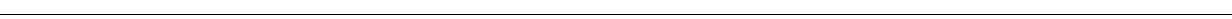
Figure 6 | Motor neuron-selective deletion of FUS does not cause MN degeneration. ( a ) MNs of t ON hFUS WT (left), t ON hFUS R521C (centre) and t ON hFUS P525L (right) animals immunostained with anti-myc (red, top) and anti-FUS (green, bottom) antibodies. White arrows indicate cells with no nuclear staining for myc-hFUS (red) and endogenous mFUS (green). Scale bar, 25 m m. ( b ) Illustration of the conditional FUS allele (FUS FLOX ) and the null FUS allele (FUS KO* ). In the FUS FLOX allele, exons 4–6 of murine FUS are flanked by LoxP (red triangles) recombination sites. Cre-dependent excision of exons 4–6 produces the FUS KO* allele. ( c ) Western blot analysis of total brain extracts with anti-FUS antibody in p10 wild-type controls (WT/WT) and animals homozygous for the conditional FUS allele (FLOX/FLOX). ( d ) Using primers specific to exons 12–14, in p0 total brain extracts, FUS transcript abundance in FUS null ( FUS KO*/KO* , light grey) was 4.1 ± 0.3% relative to wild-type controls (dark grey) animals. Similar results (6.7 ± 0.8%) were obtained using primers specific to exons 1–3 ( N ¼ 3). ( e ) Western blot analysis of total brain extracts from p0 wild-type (WT/WT), heterozygous FUS null (WT/ KO*) and homozygous FUS null (KO*/KO*). No protein products were observed in FUS KO*/KO* animals using N-terminal anti-FUS antibody (ab84078). Similar results were obtained using antibodies raised to the middle and the C-terminus of the FUS protein (Supplementary Fig. 4D). ( f ) Quantification of the fraction of MNs (ChAT þ ) that were also FUS þ in control (black) and FUS-KO MN (grey) animals. The majority of MNs (67.1 ± 5.6%) were already immunonegative for FUS by p4 and by p30 the elimination of FUS from MNs was complete (99.5 ± 0.3%). N ¼ 3. ( g ) Immunostaining of L5 spinal cords from p360 control (left) and FUS-KO MN (right) animals for FUS (red) and ChAT (white). Boxed area is reproduced at higher magnification in the bottom panels. Scale bar, 100 m m (top), 25 m m (bottom). ( h ) Percentage of MNs in the L5 spinal cord normalized to control (top) and the percentages of innervated NMJs in the TA muscle (bottom) in p360 control (dark grey) and FUS-KO MN (light grey) animals. N ¼ 4. (For f – h : Control ¼ FUS FLOX/ WT ;ChAT-Cre þ / (cid:2) and FUS-KO MN ¼ FUS FLOX/ KO ;ChAT-Cre þ / (cid:2)